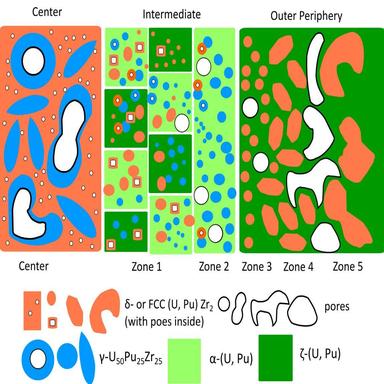
A schematic drawing (not down to scale) of the Zr phase redistribution and the major matrix phases present in the irradiated U-Pu-Zr fuel. The most Zr-bearing phase, δ-(U, Pu)Zr2 is found to play different roles along the radial locations. In the center, δ-(U, Pu)Zr2 is the matrix phase, lifting the local Zr concentration to ∼40 wt.%. In the intermediate region where the Zr concentration plunged, the δ-(U, Pu)Zr2 dispersed in a matrix of α- (U, Pu) and ζ - (U, Pu) as nano precipitates. In the outer peripher